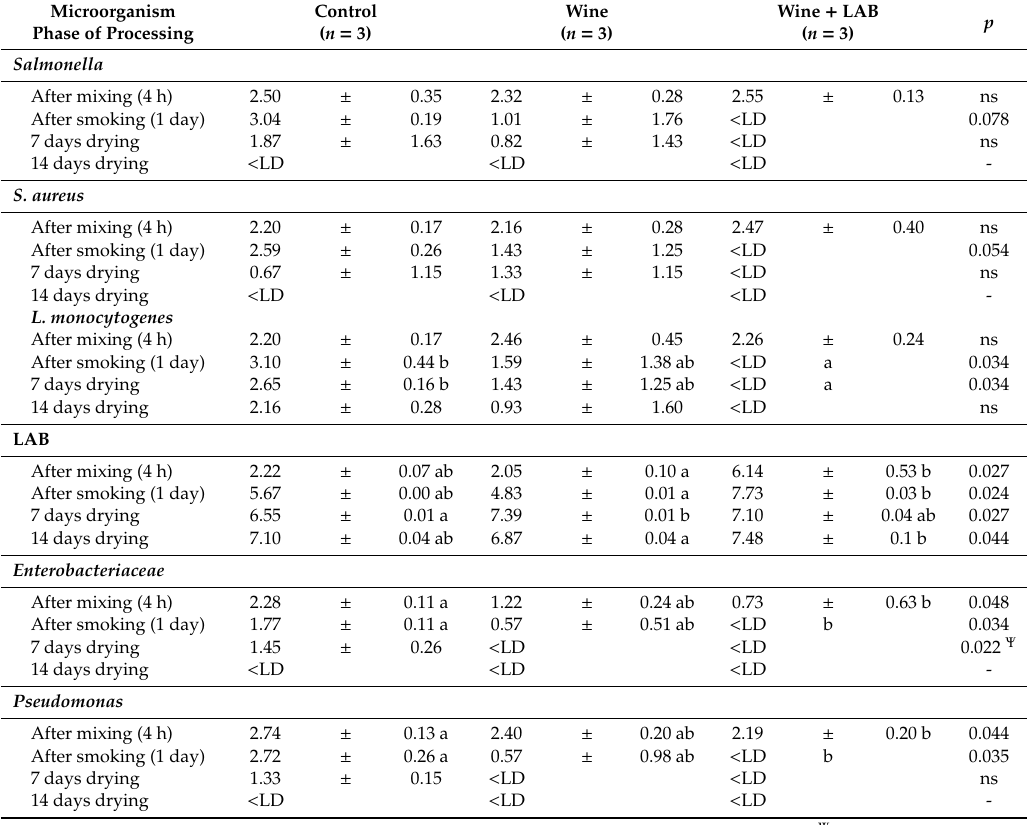
Table 3. Counts of the three pathogens in the present study and LAB in chouriço made without wine (control), supplemented with 7.5% red wine (wine) and with the additional inoculation of 6 log cfu / g L. sakei (Wine + LAB). The results are expressed as the mean ± standard deviation of log cfu / g. Microorganism Control Phase of Processing ( n =